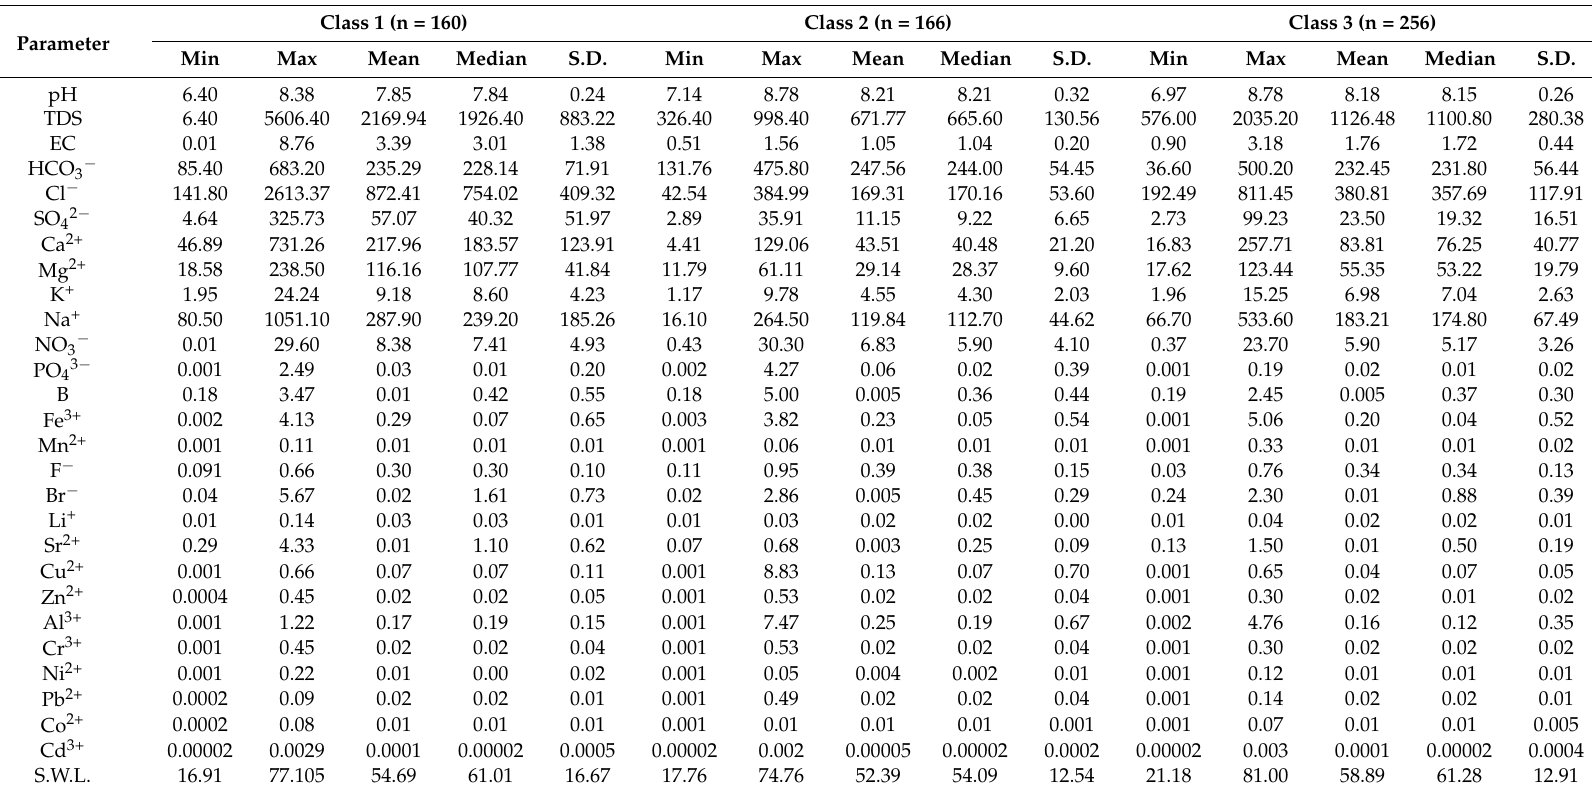
Table 4. Statistics of the three categories found from the K-means clustering